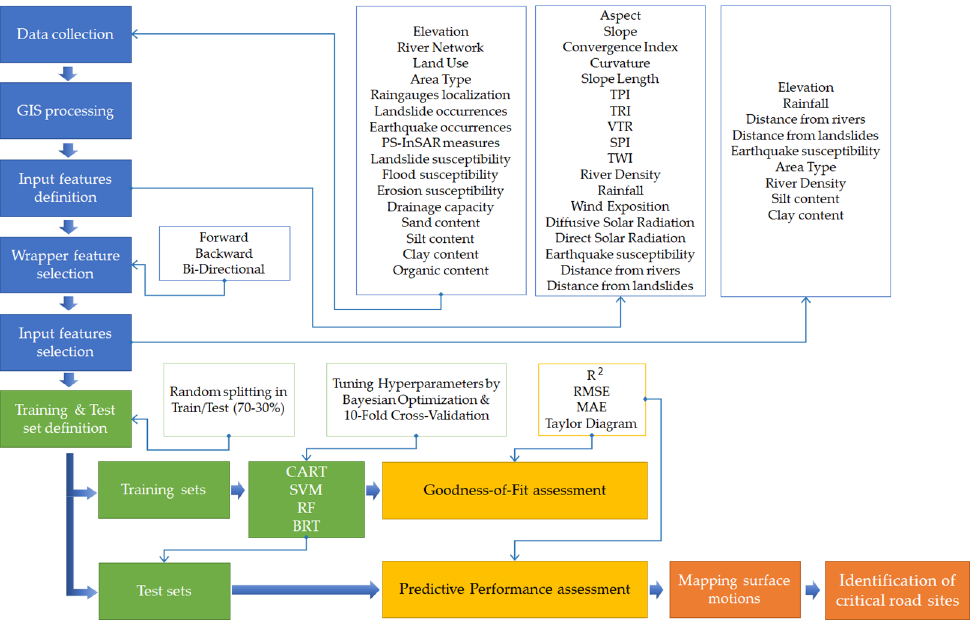
Figure 3. The workflow of the proposed approach.